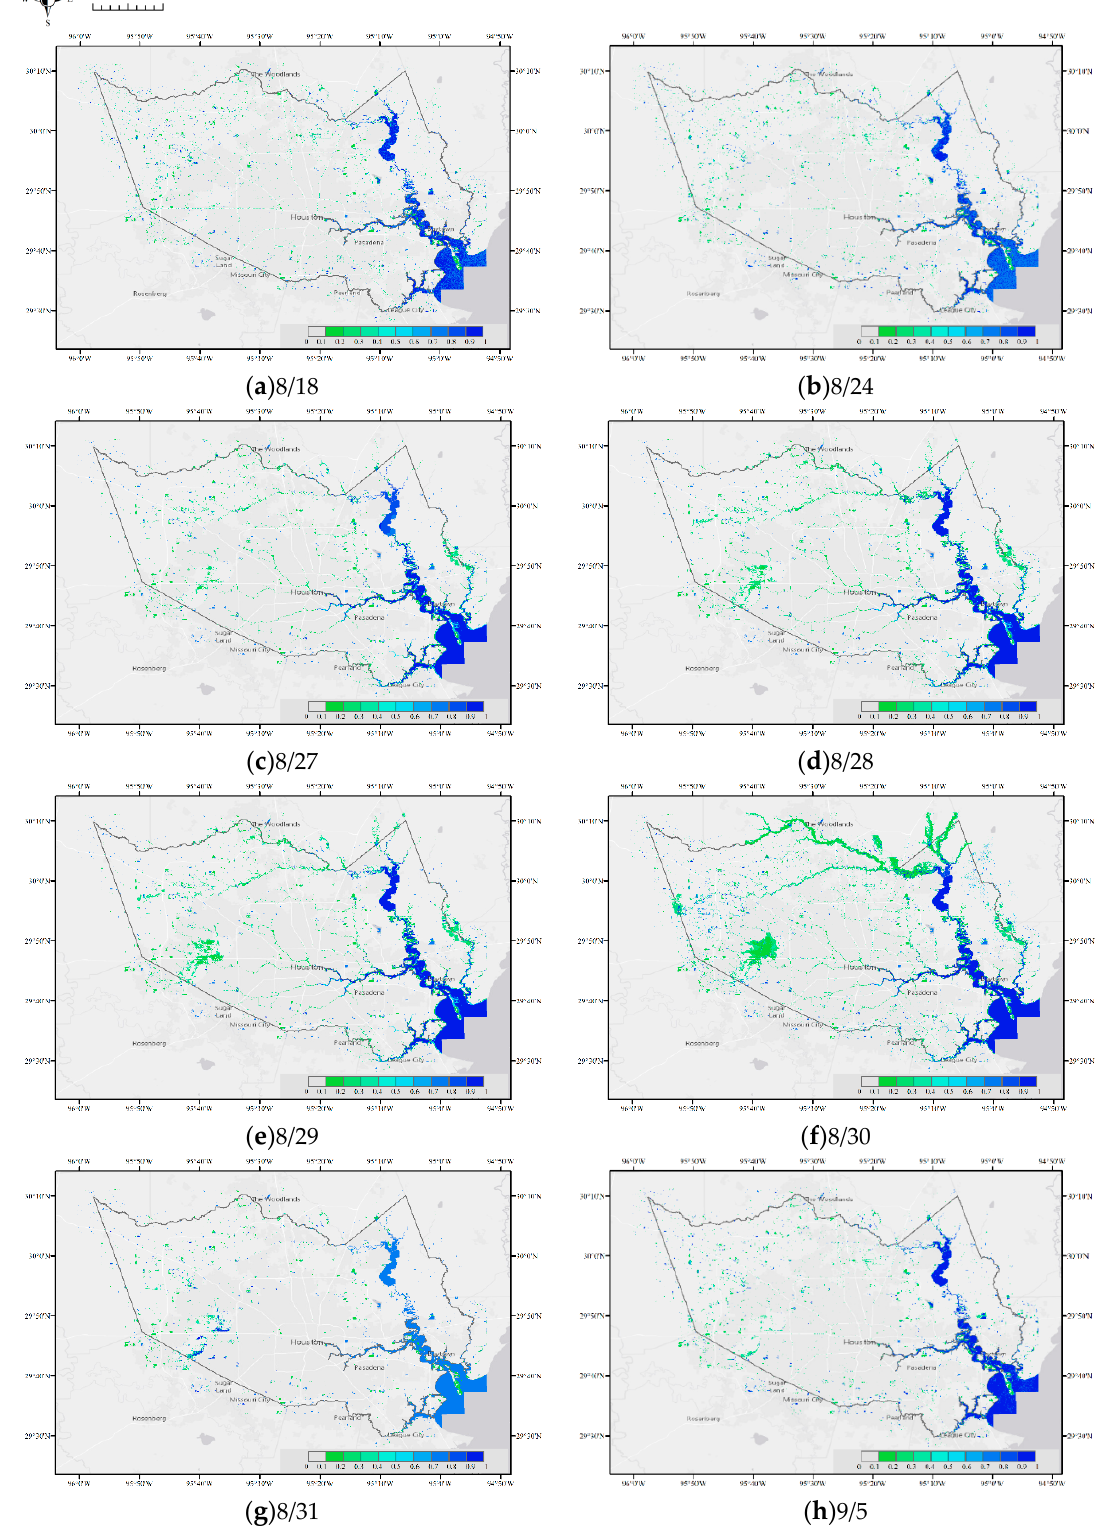
Figure 8. ( a – h ) The posterior probability of inundation from 18 August to 5 September 2017.